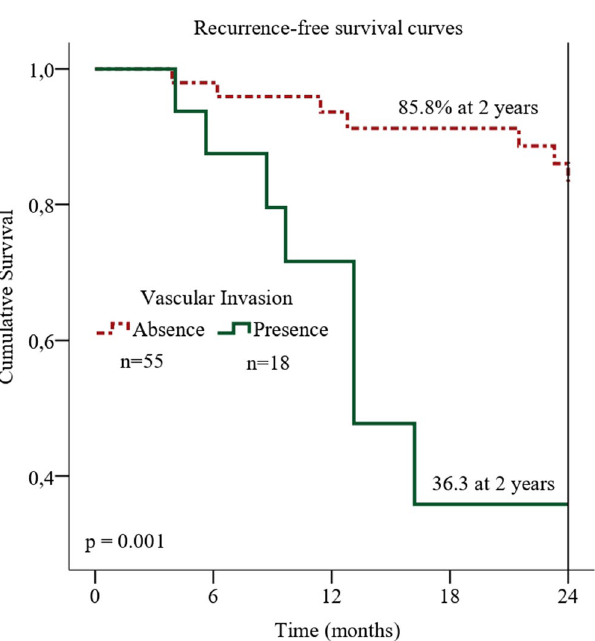
Figure 2. Overall survival plot. Kaplan–Meier curve is shown for overall survival in patients with squamous cell carcinoma of the oral cavity according to ( A ) current alcohol consumption and ( B ) vascular invasion.